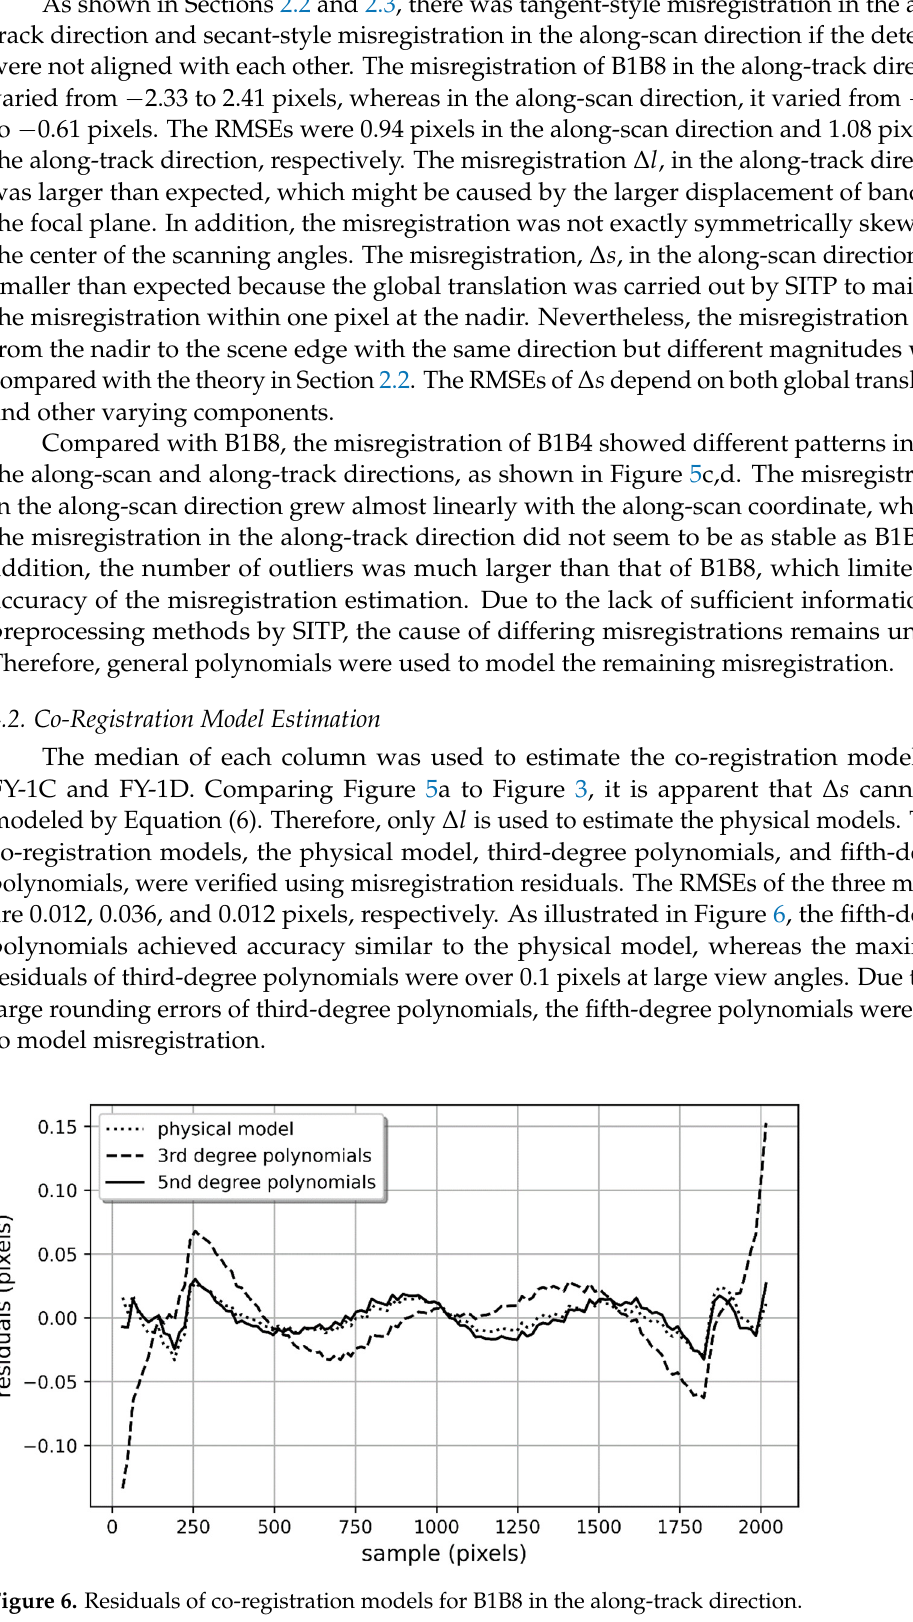
Figure 7. Band-to-band misregistration of FY1C/1D before co-registration. ( a ) the misregistration of FY-1D in the along-scan direction. ( b ) the misregistration of FY-1D in the along-track direction. ( c ) the misregistration of FY-1C in the along-scan direction. ( d ) the misregistration of FY-1C in the along-track direction.